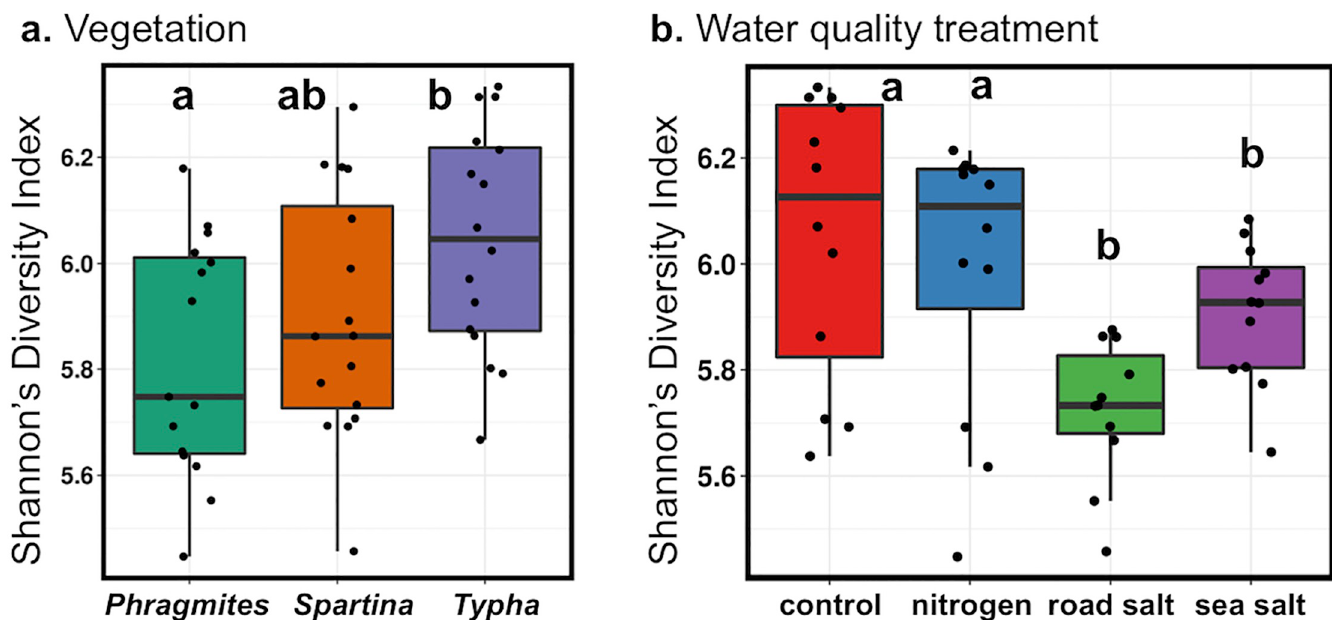
Fig 6. Bacterial diversity in sequence datasets. (a) Diversity in datasets grouped by vegetation type. (b) Diversity in datasets grouped by water quality treatment. Significant differences between groups are indicated by non-overlap of letters, based on post-hoc Tukey contrasts.